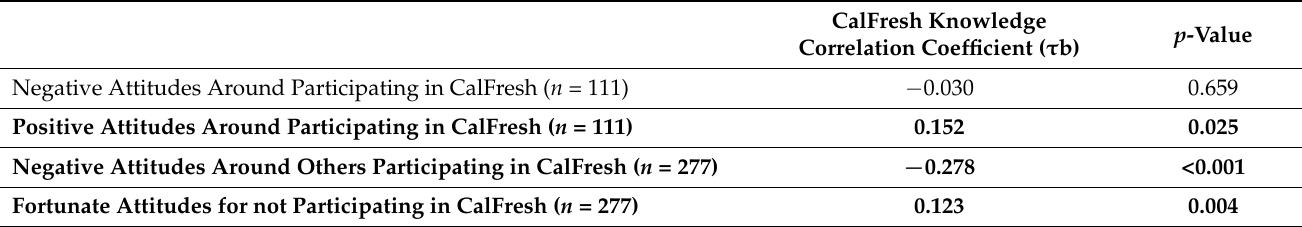
Table 3. Kendall’s tau Correlation of CalFresh Knowledge and Attitudes towards